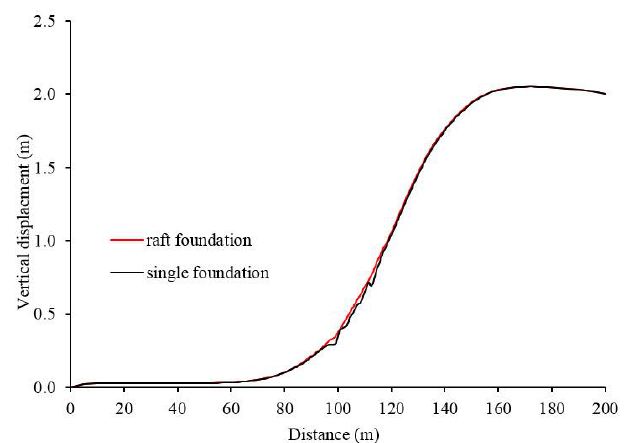
Fig. 18. Comparison of vertical displacement of ground for 5 floor building with single and raft foundation with DS-LS density.